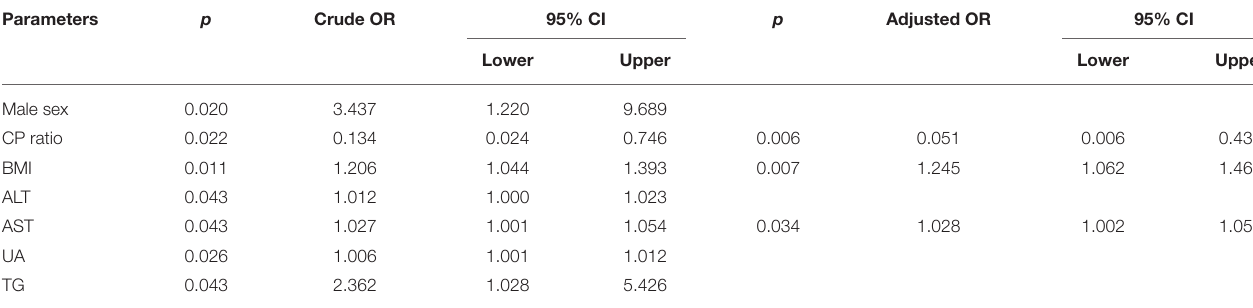
TABLE 3 | Univariate and multivariable analysis. Parameters